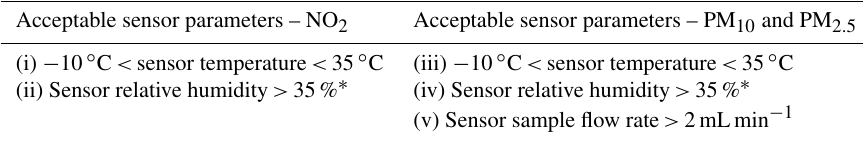
Figure 2. Schematic of the sensor baseline correction model including interfaces with the downstream RFR interference correction model. Table 1. Filtering criteria used for the initial screening out of anomalous sensor